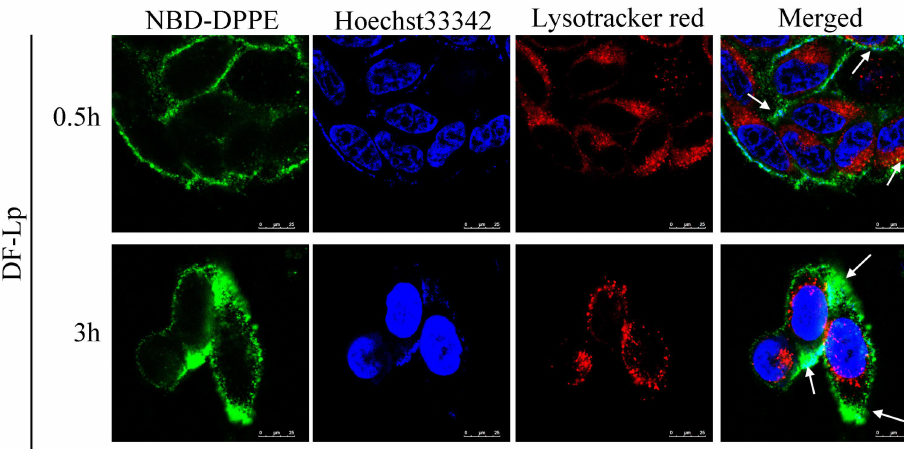
Figure 4. Colocalization of NBD-DPPE labeled dual-modified liposomes (DF-Lp, green) and endosomes / lysosomes (red). Nuclei were stained with Hoechst 33342 (blue). Scale bar = 25 µ m. Anti-proliferative e ff ects of the tested liposomes in vitro were evaluated on